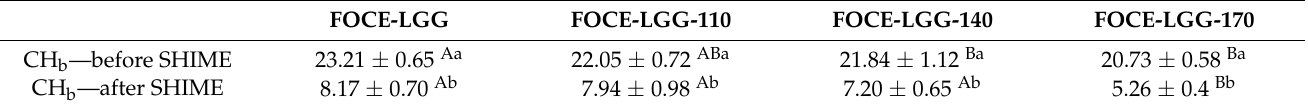
Table 6. Cholesterol biding ability (%) of FOCE-LGG samples before and after simulated passage through